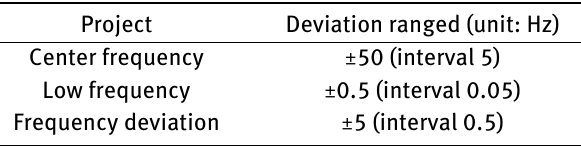
Table 2: Technical indexes of two types of frequency shifter trans- mission boxes